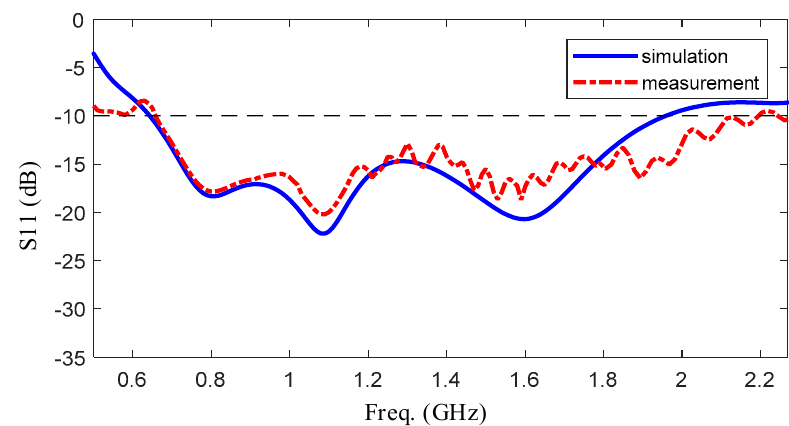
Figure 16. The comparison of reflection coefficient between measurement and simulation.